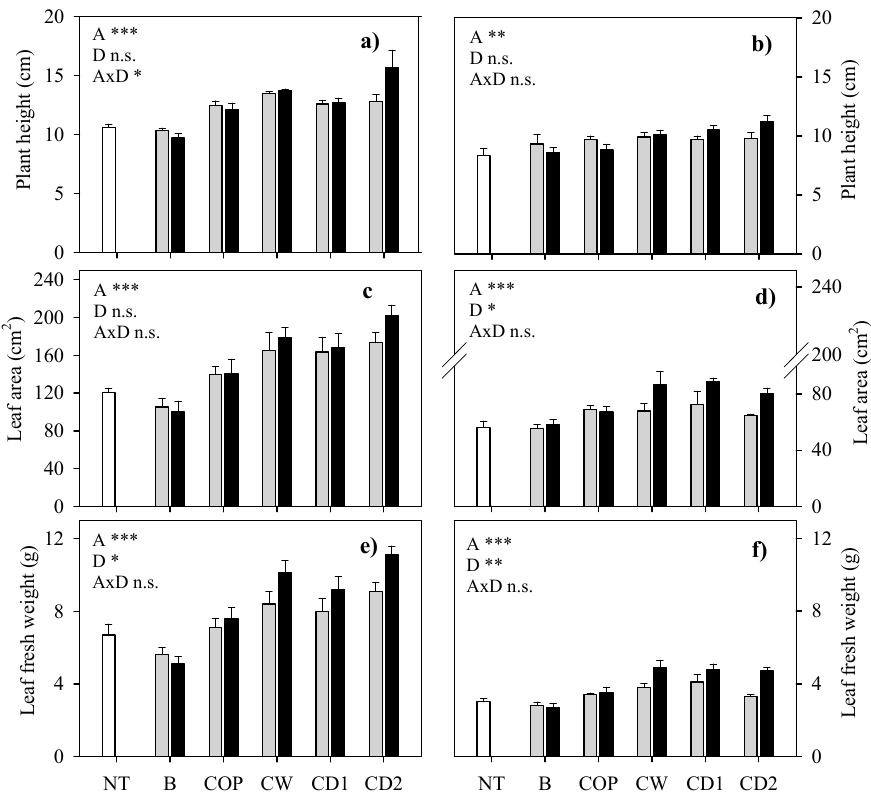
Figure 2. Plant height ( a , b ), leaf area ( c , d ) and leaf fresh weight ( e , f ) of Swiss chard treated with di ff erent organic amendments (B, biochar; COP, compost from olive pomace; CW, vermicompost